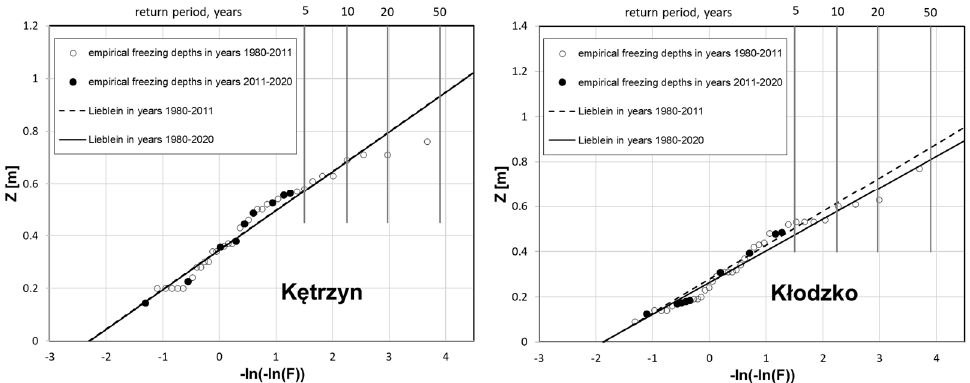
Figure 8. Comparison of predicted and measurement value for chosen location: Jelenia Góra ( left ) and Kalisz ( right ) station.